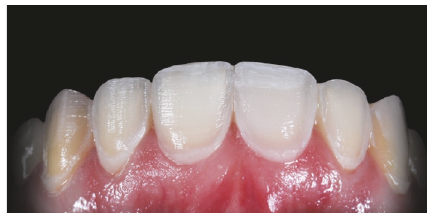
Figure 3: Wax-up, identical in form from the DSD.